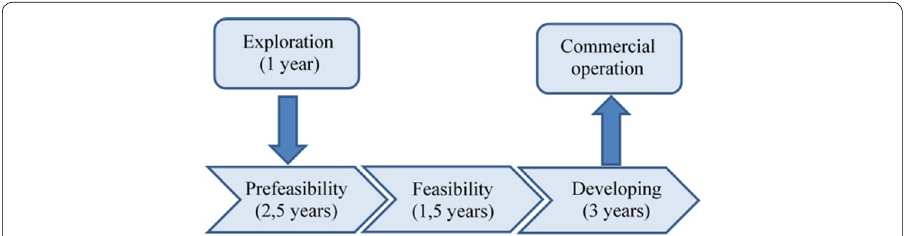
Fig. 4 Idealized scheme of the geothermal plant development stages (Reproduced with permission